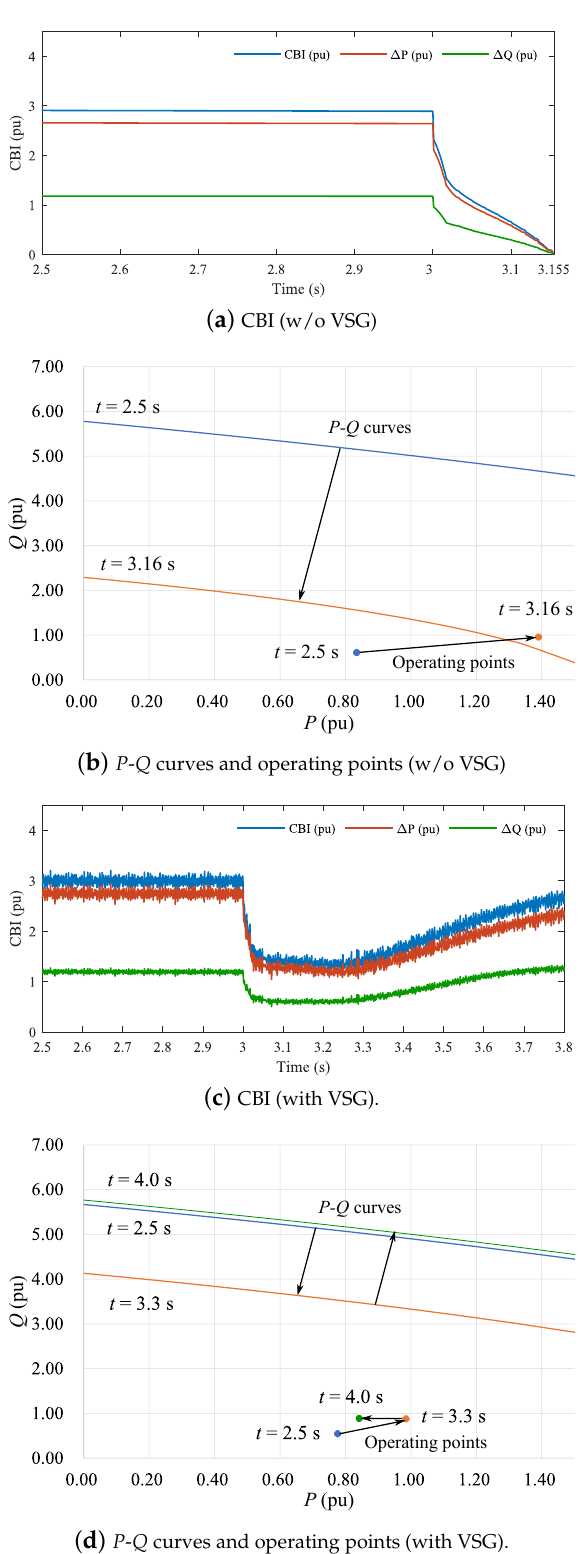
Figure 16. Critical boundary index (CBI) in Case 1.3 with/without